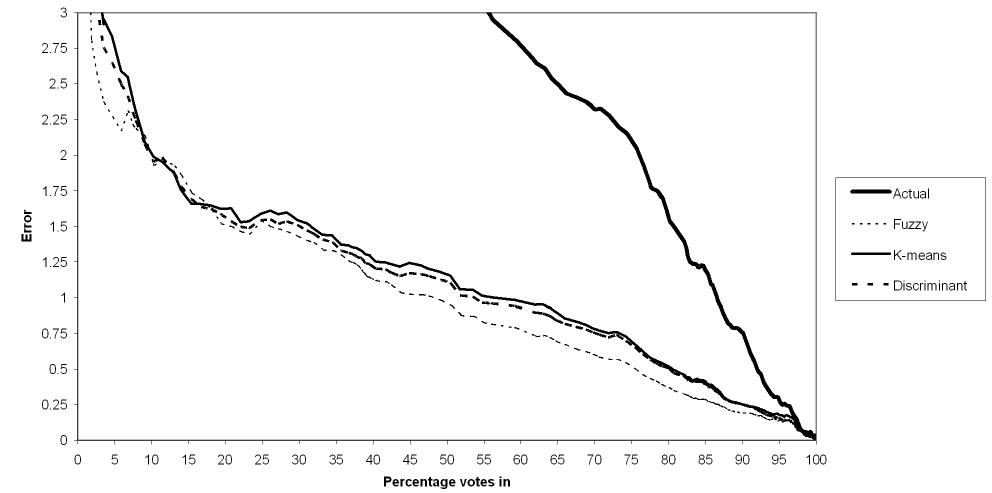
Figure 4: Comparison of the average error E ( t ) for three cluster methods used in the predictions of the 2004 national election results (based on clusters developed from the 1999